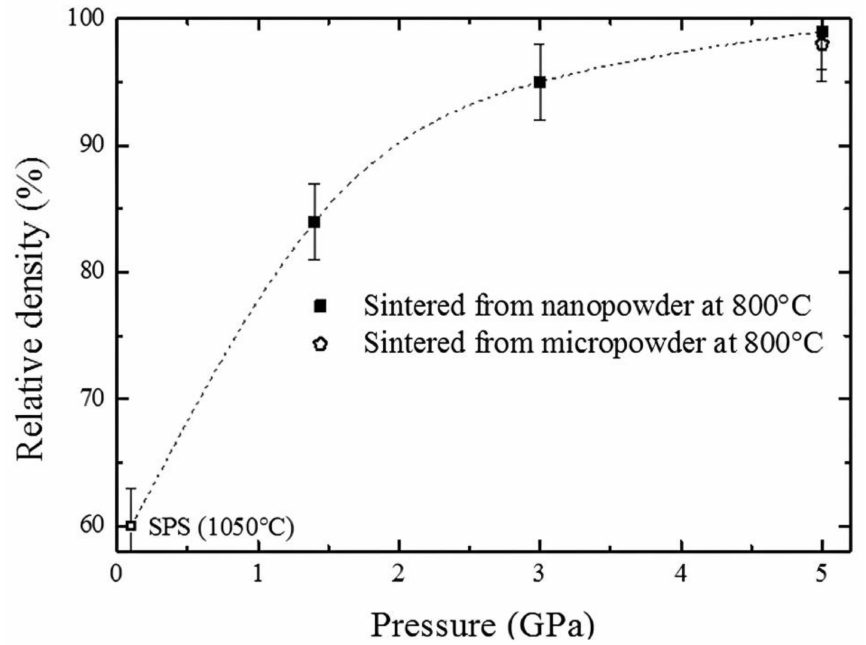
Figure 12. Density evolution with pressure in recovered α -Al 2 O 3 ceramics sintered at 800 ◦ C from γ -Al 2 O 3 with nano or micro-sized grains. The first symbol at lowest pressure corresponding to conventional SPS (100 MPa). (Figure adapted from [61]).